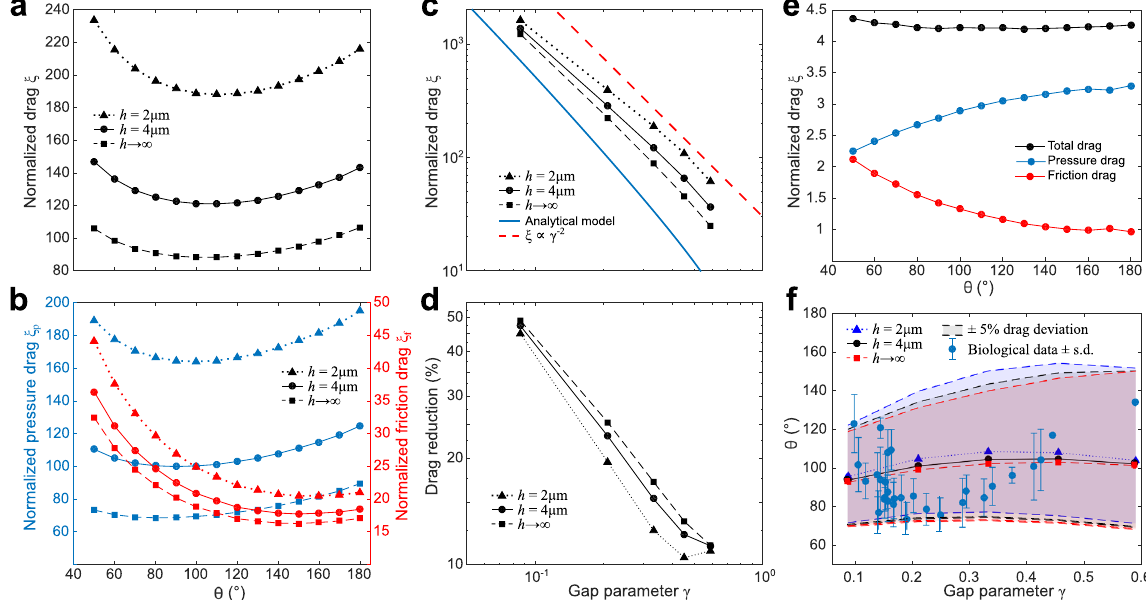
Figure 4. Dependence of the drag on hair-bundle shape for flow across a row of hair bundles. Results are shown from 3D simulations with short ( h = 2 μ m, triangles) and tall ( h = 4 μ m, circles) hair bundles, as well as from 2D simulations which are equivalent to infinitely tall hair bundles (squares). ( a ) The normalized drag for a given gap parameter (here γ = 0.33) is minimal for a hair-bundle shape with tip angle θ ≈  ⁎ 100 . ( b ) The minimal num drag at the optimal angle emerges from a trade-off between friction drag (red) and pressure drag (blue). ( c ) The drag increases with decreasing gap parameter γ approximately as γ − 2 for a hair bundle with an angle θ θ = ≈  ⁎ 100 . ( d ) The reduction in drag at the optimal angle compared to the case θ = 180° is larger for num smaller gap sizes. ( e ) The total drag on a single hair bundle in unbounded flow shows little dependence on the shape of the bundle and varies by only about 3.7%. Significant drag reduction for V-shaped hair bundles as shown in panels a and d is therefore particular to dense rows of hair bundles as found in the cochlea. ( f ) The numerically-computed optimal angle of the hair bundle’s shape varies slightly with gap sizes (blue, black, and red lines with markers), and so does the range of angles for which the drag is at most 5% higher than at the optimal angle (shading in corresponding colors). All biologically-observed angles of outer hair cells’ hair bundles fall into this